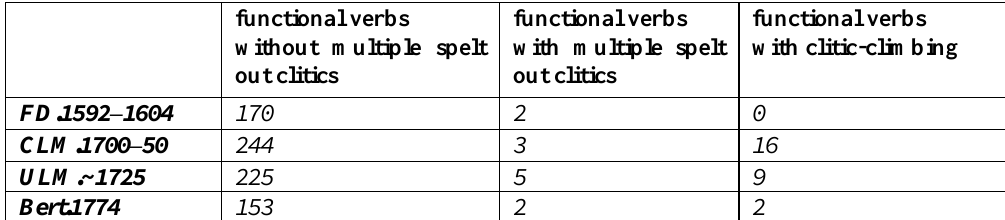
Table 2. Multiple spelt out clitics and clitic-climbing in old Daco-Romanian functional verbs functional verbs functional verbs without multiple spelt with multiple spelt with clitic-climbing out clitics out clitics FD.1592–1604 170 2 0 CLM.1700–50 244 3 16 ULM.~1725 225 5 9 Bert.1774